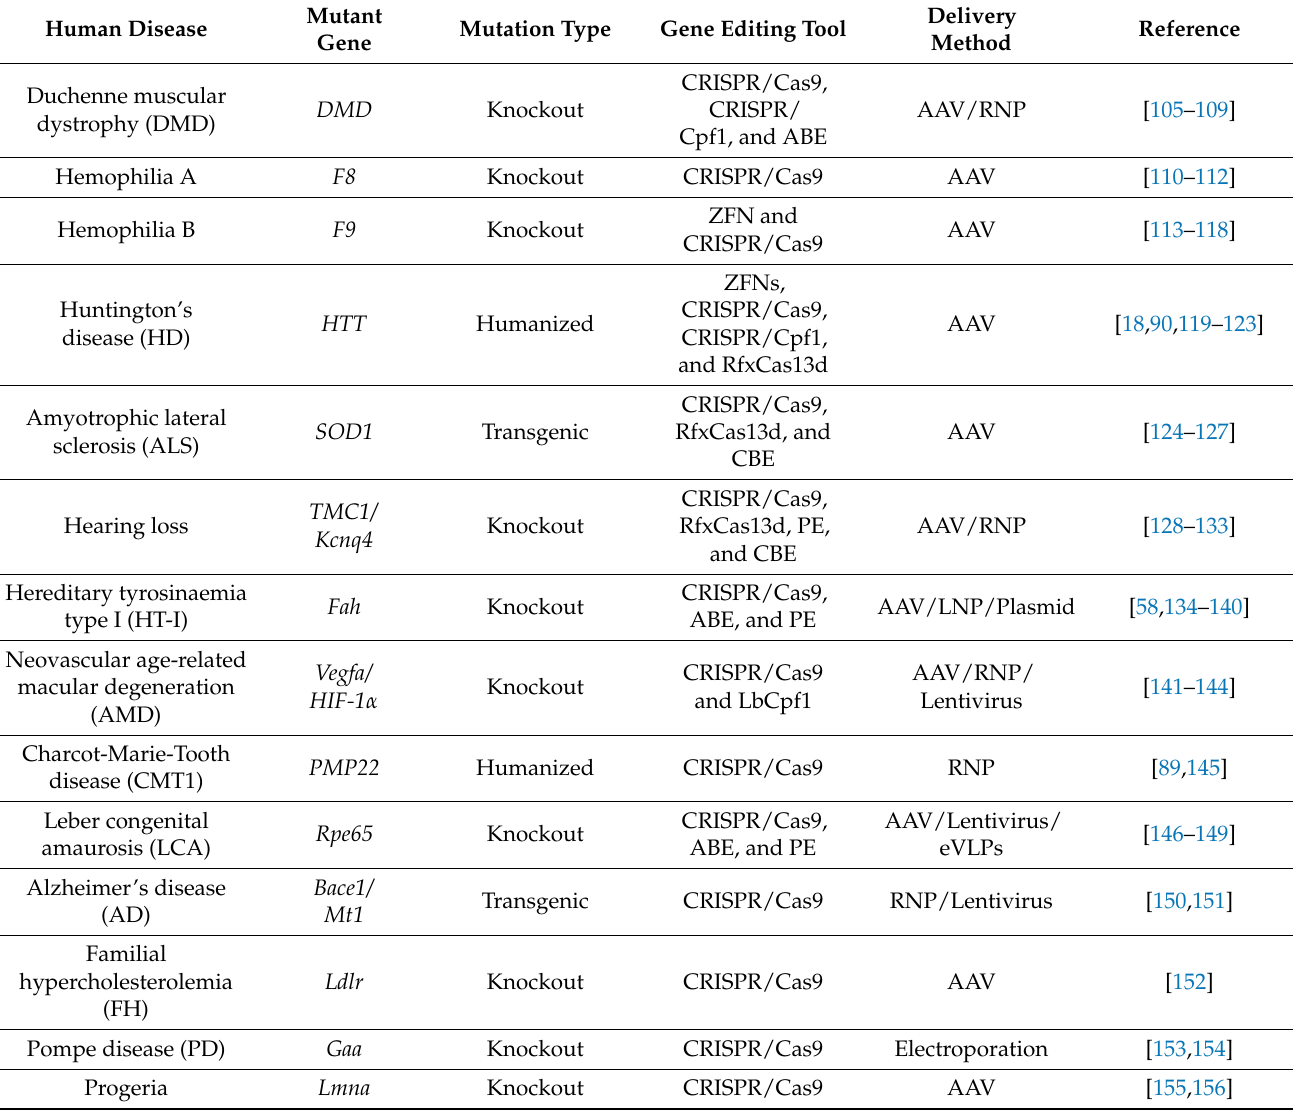
Table 2. Gene editing-mediated therapeutics using mouse models of human disease. Human